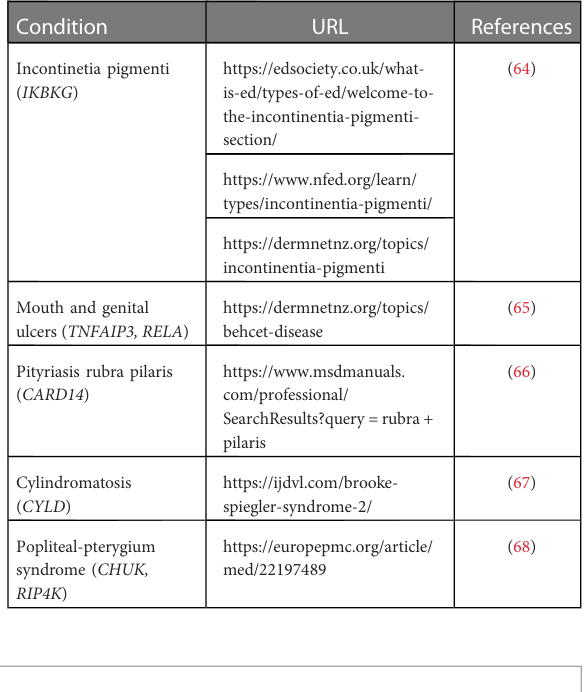
TABLE 3 Links to images of conditions